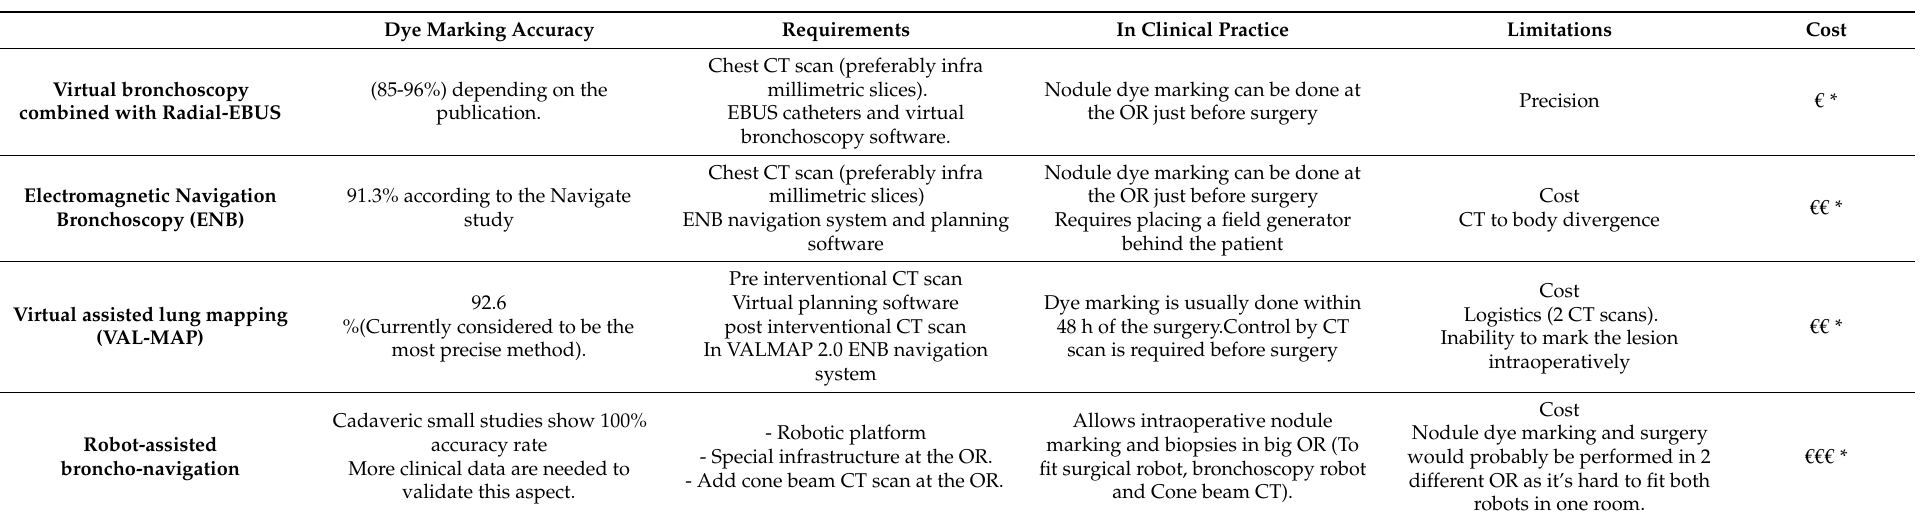
Table 1. Summary of bronchoscopic techniques in nodule